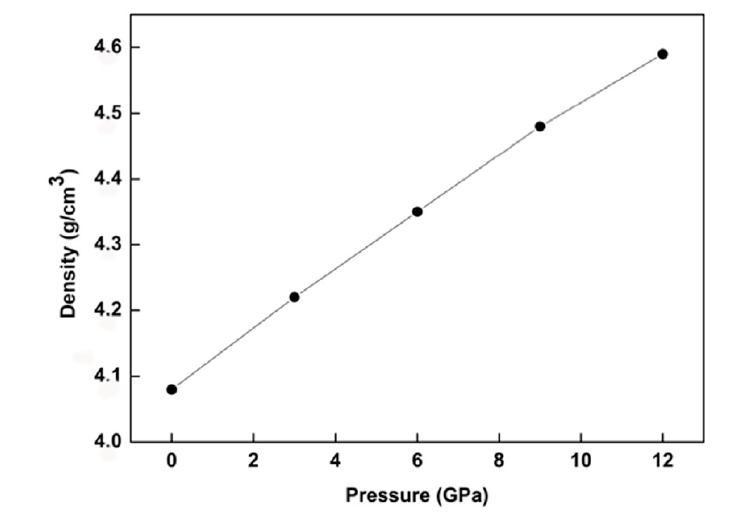
Figure 1. Density behavior of wurtzite (WZ) ZnS under